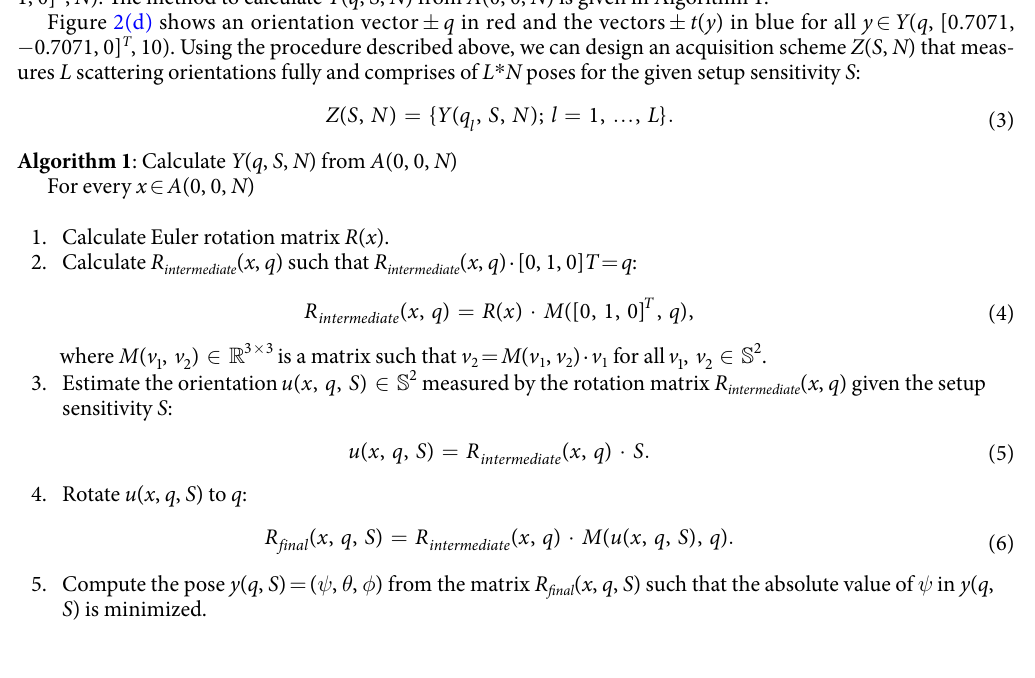
vector denotes the scattering orientation that is probed at the acquisition pose x while the tomographic vector represents the direction along which the signal is integrated.